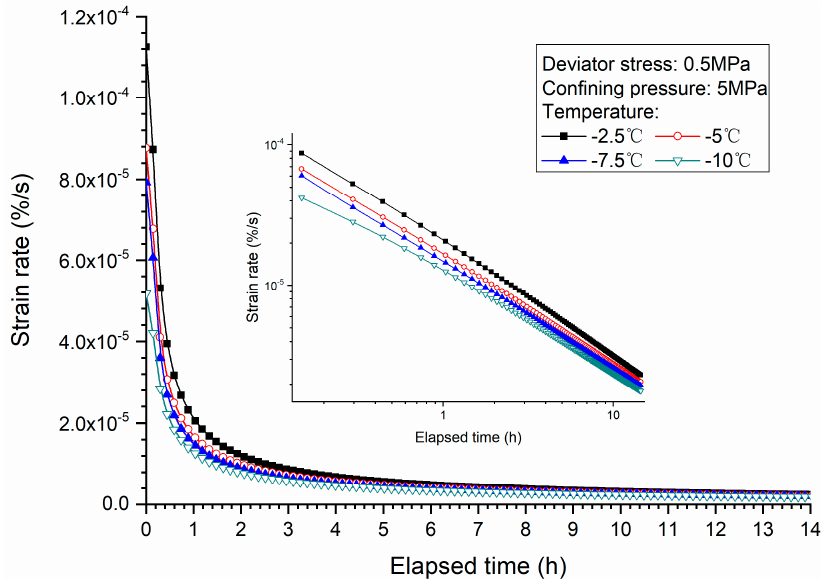
Figure 12. Creep strain rate versus elapsed time for methane hydrate-bearing frozen specimens under various temperatures. Energies 2019 , 12 , x FOR PEER REVIEW 13 of 17